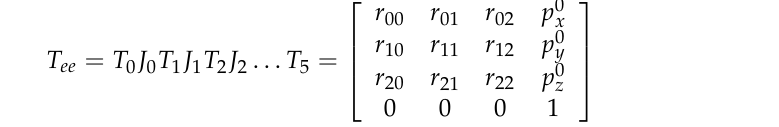
Figure 9. System architecture.